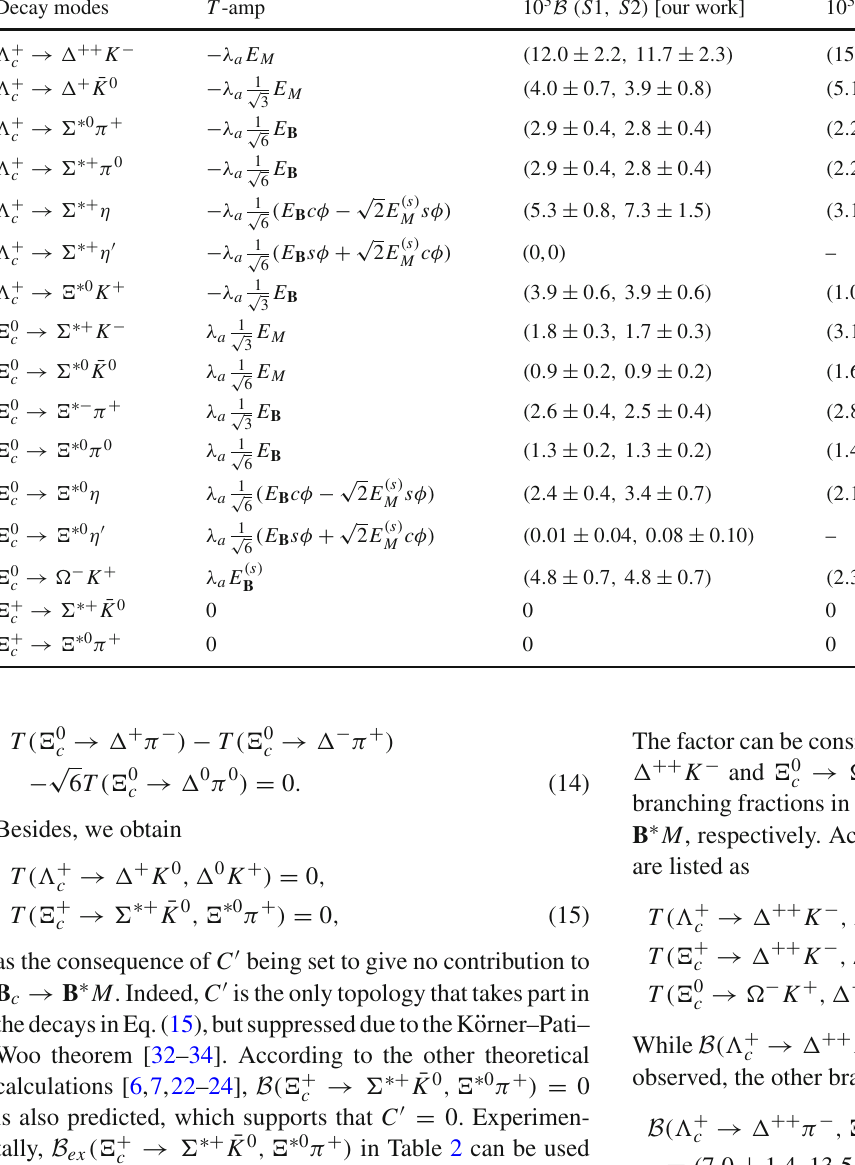
Table 1 Cabibbo-allowed B c → B ∗ M decays Decay